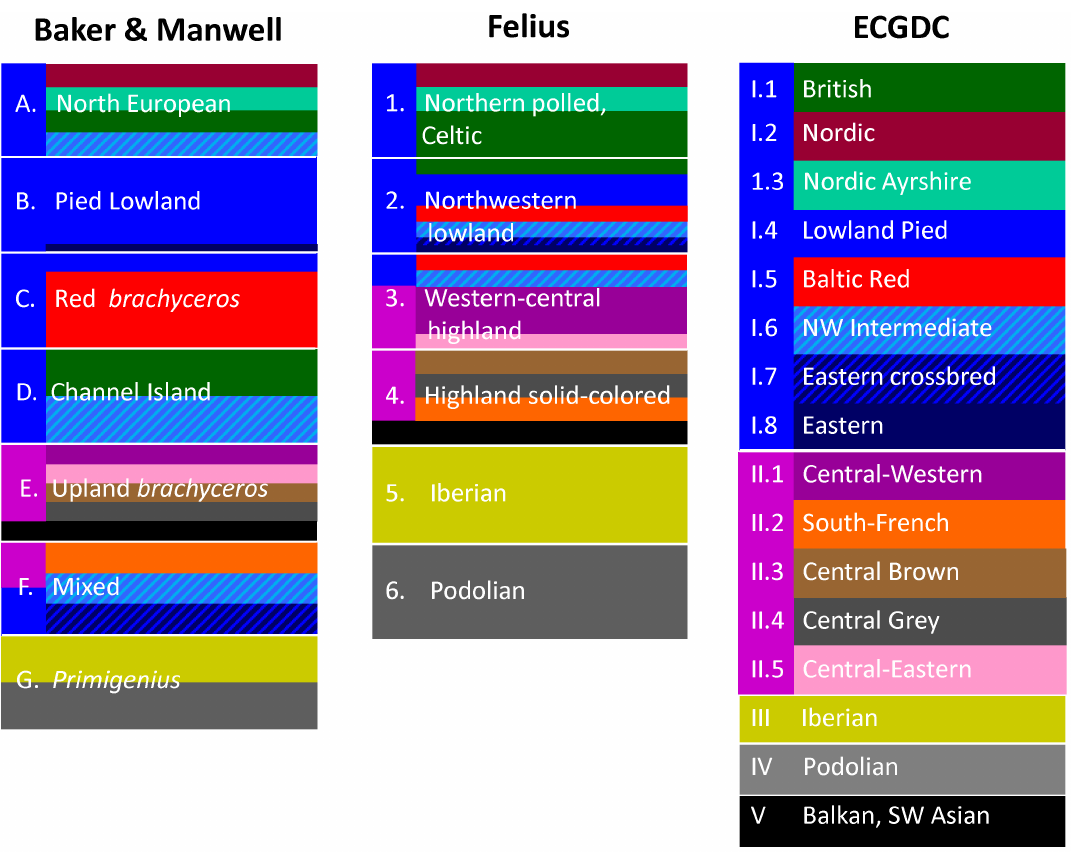
Figure 10. Comparison of the biochemical classification from Baker and Manwell [13], the integrated classification from Felius [2] and the microsatellite-based classification of the European Cattle Genetic Diversity Consortium (ECGDC). The horizontal color bars indicate the groups of the genetic classification. Even colors denote clusters of breeds that are more related to each other than to breeds of other clusters. Hatched colors denote groups of neighboring intermediate or crossbred breeds. The horizontal blocks at the left containing the numbering indicate the five main genetic types of cattle: northern European (blue); central European (violet); Iberian (ochre); Podolian (grey); and Balkan with Anatolian